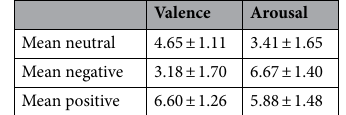
Table 1. Average self-reported valence and arousal scores per video